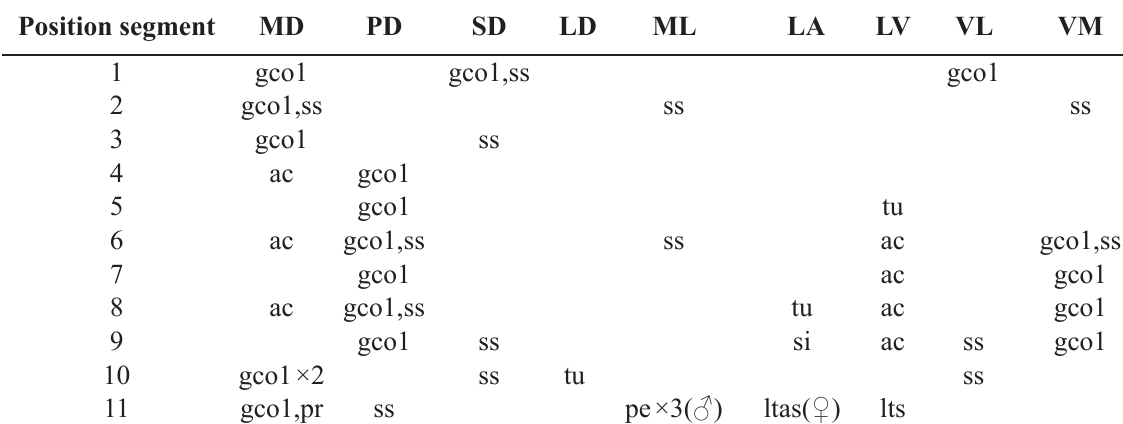
Table 15. Summary of nature and location of sensory spots, glandular cell outlets, tubes and spines arranged by series in Echinoderes samwisei sp.